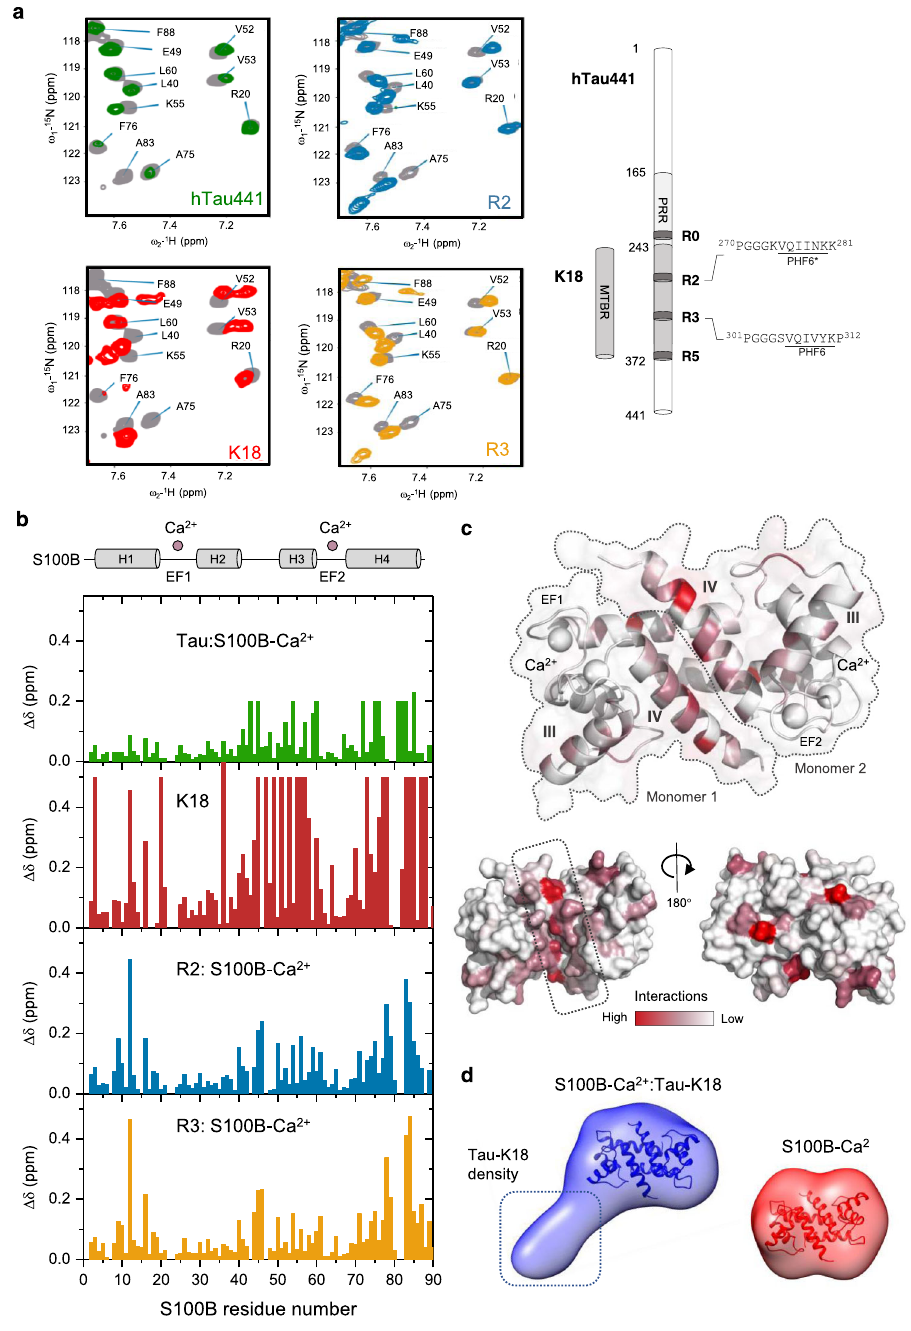
Fig. 3 Mapping tau interactions to S100B. a Zoom of HSQC spectra evidencing chemical shift perturbation of 100 µ M 15 N-S100B residues in the presence of 1.25 mM CaCl 2 and 160 µ M full-length tau (green), 100 µ M K18 (or MTBR, red), 250 µ M of R2 (blue) and R3 peptide (yellow). Spectra changes upon binding of tau (green), K18 (red), and R2 (blue) and R3 (yellow) peptides to S100B-Ca 2 + (alone in gray). b Plots of the chemical shift perturbation along S100B sequence following addition (from top to bottom) of full-length tau (molar ratio 1:1.6), tau K18 fragment (molar ratio 1:1), and tau peptides (molar ratio 1:2.5). Peaks broadened beyond detection are represented with a fi xed arbitrary value of 0.2 (with tau) and 0.5 (with K18). Parts per million (ppm). A scheme of the secondary structures of S100B is presented above the plots, scaled according to the sequence of the x axis. c 3D mapping of the R2:S100B- Ca 2 + spectral perturbations identi fi ed the S100B dimer interfacial clef (dotted box) involving helix IV as the major attachment point, chemical shift perturbations (as in a ) are color-coded on the protein surface [Protein Data Bank (PDB) code: 2H61]. See Methods for details, Supplementary Figs 7 and 9 and Supplementary Movie 1. d Ab initio SAXS-derived envelopes of S100B-Ca 2 + :K18 complex (blue) and S100B-Ca 2 + (red), see Supplementary Table 1 for data-collection and scattering-derived parameters. The crystal structure of S100B-Ca 2 + fi tted to both molecular envelopes is shown in cartoon